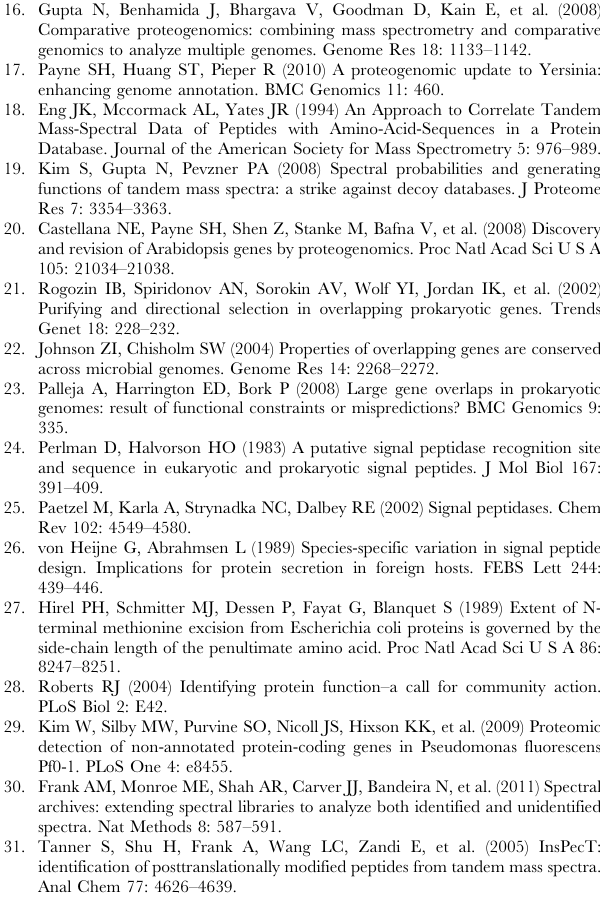
Figure S6 Length comparison. The length of all genes (grey) has a median of , 900 nucleotides with a long tail out to 10,000 nucleotides. Novel genes (blue) are on average shorter than the background distribution. However, they are not too short to have fallen below cutoff. Table S1 List of organisms presented in this study. Along with each organism is listed the following information: the percent GC of the genome, the date of genome submission to genbank, the RefSeq accession of the primary chromosome, the genome size in megabases, the number of novel genes discovered through proteogenomics, the number of genes for which proteomics data suggests a new start site, the number of validated signal peptide cleavages, the total number of peptides discovered in the MS/MS data for an organism. Table S2 Gene conflicts. This table presents the number of conflicting loci, separated by type, for each genome.